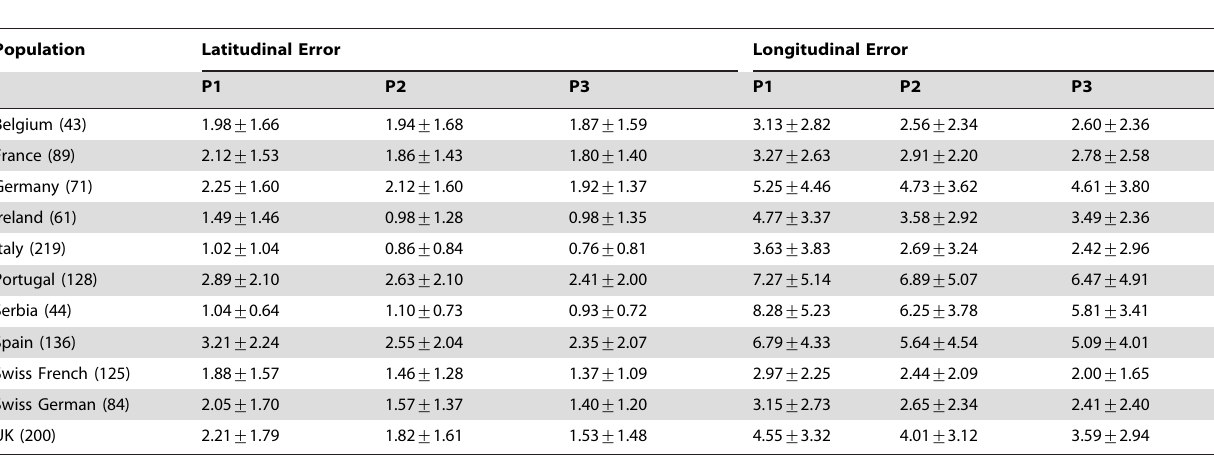
Table 2. Latitudinal and longitudinal errors of our full leave-one-out crossvalidation experiment on 1,200 samples from 11